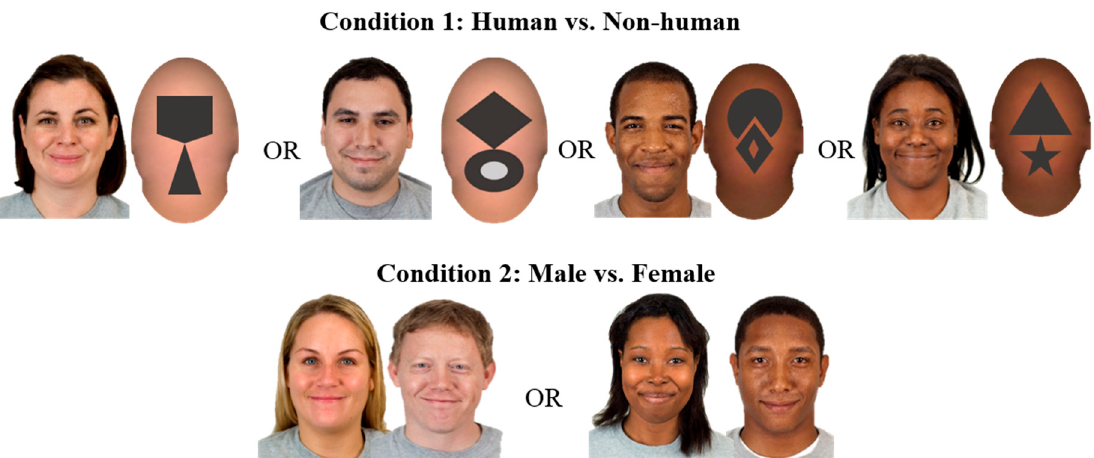
Figure 1. Example of face identities. Condition 1 infants were presented with human versus non-human images on foam-core blocks. Faces were either male or female paired with non-human image. Condition 2, infants were presented with male versus female faces. In both conditions infants either saw Caucasian or African American faces. There were a total of 6 different face identities for each face race group.